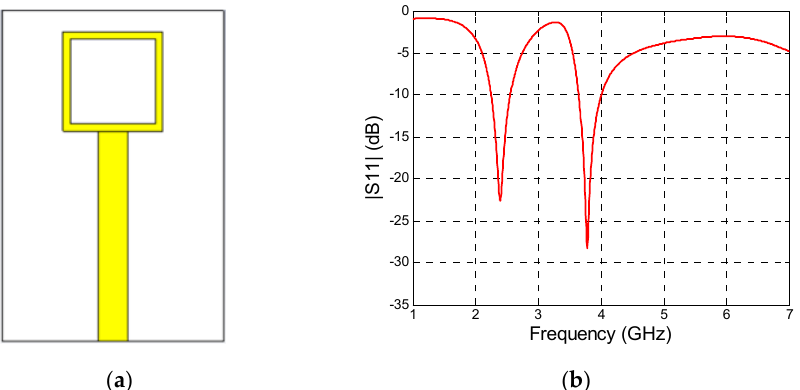
Figure 3. ( a ) The square ring radiator element and ( b ) Its simulated reflection coefficient response.